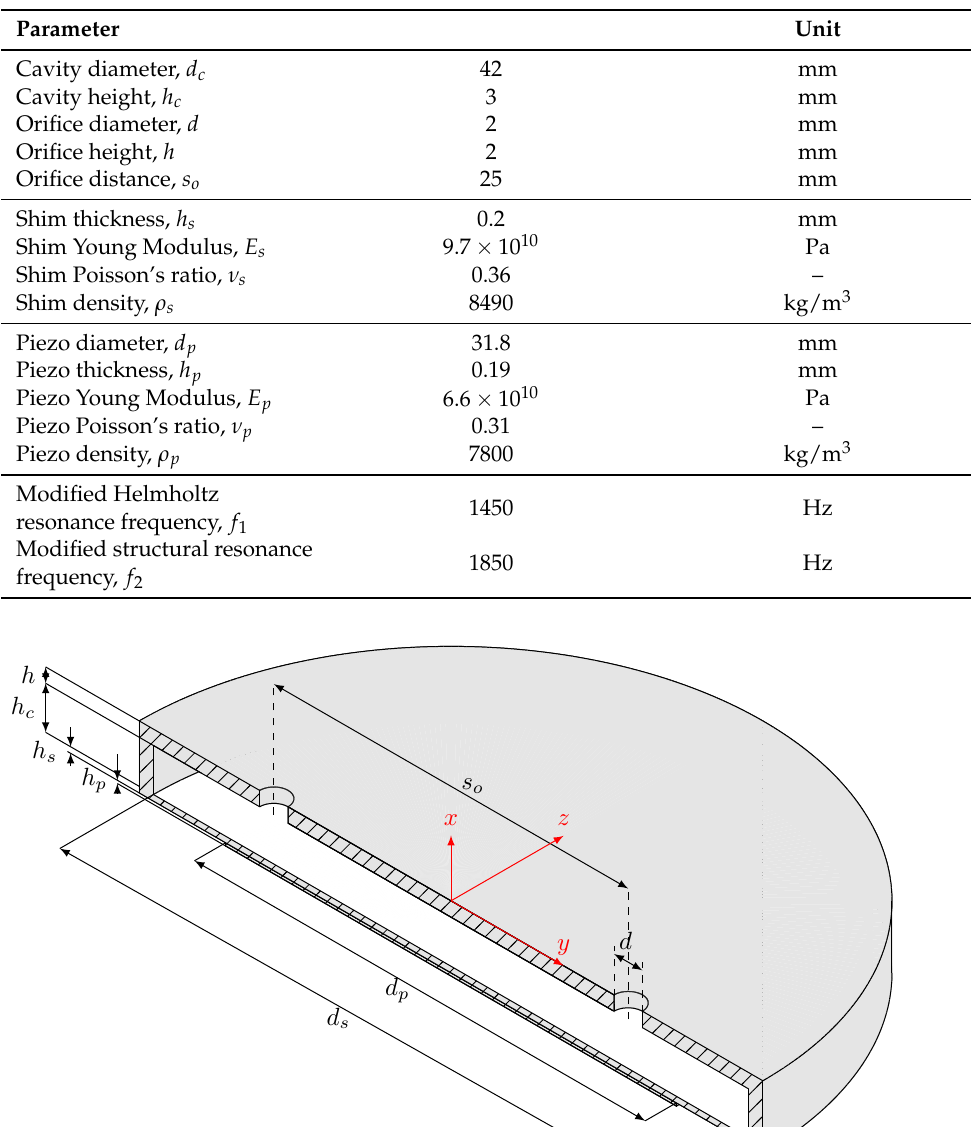
) s and ( ) p refer to the shim and piezo-element properties. · ·